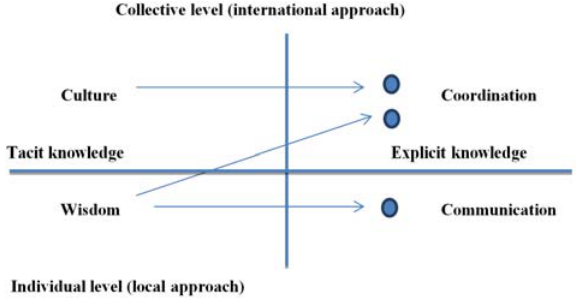
Fig. 1. A model for illustrating a local approach within an international network (the business